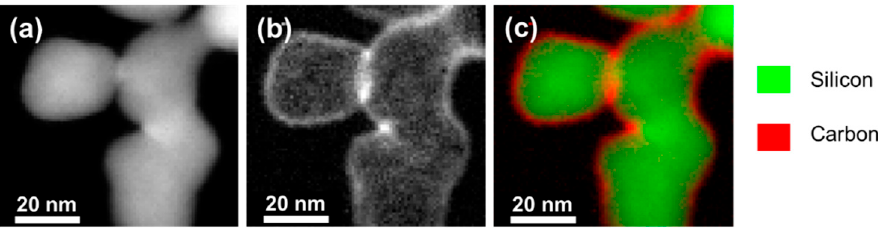
Figure 2. STEM–EELS (pictures of the Si@C materials). ( a ) silicon signal, ( b) carbon signal, ( c ) super- position of the two signals. Si is depicted in green and C in red. The core-shell structure of the ma- terial is demonstrated.